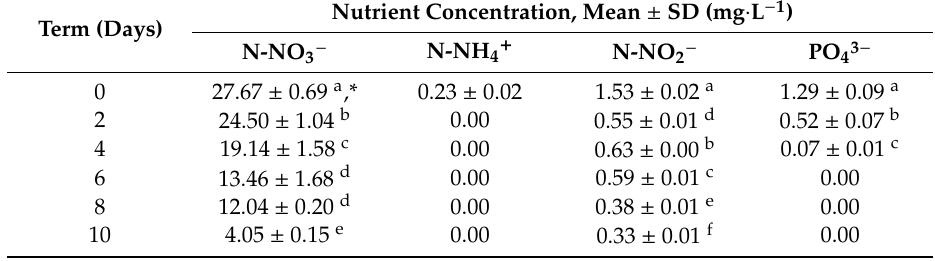
Table 4. Changes in nutrient concentration observed during the cultivation of Monoraphidium sp. in